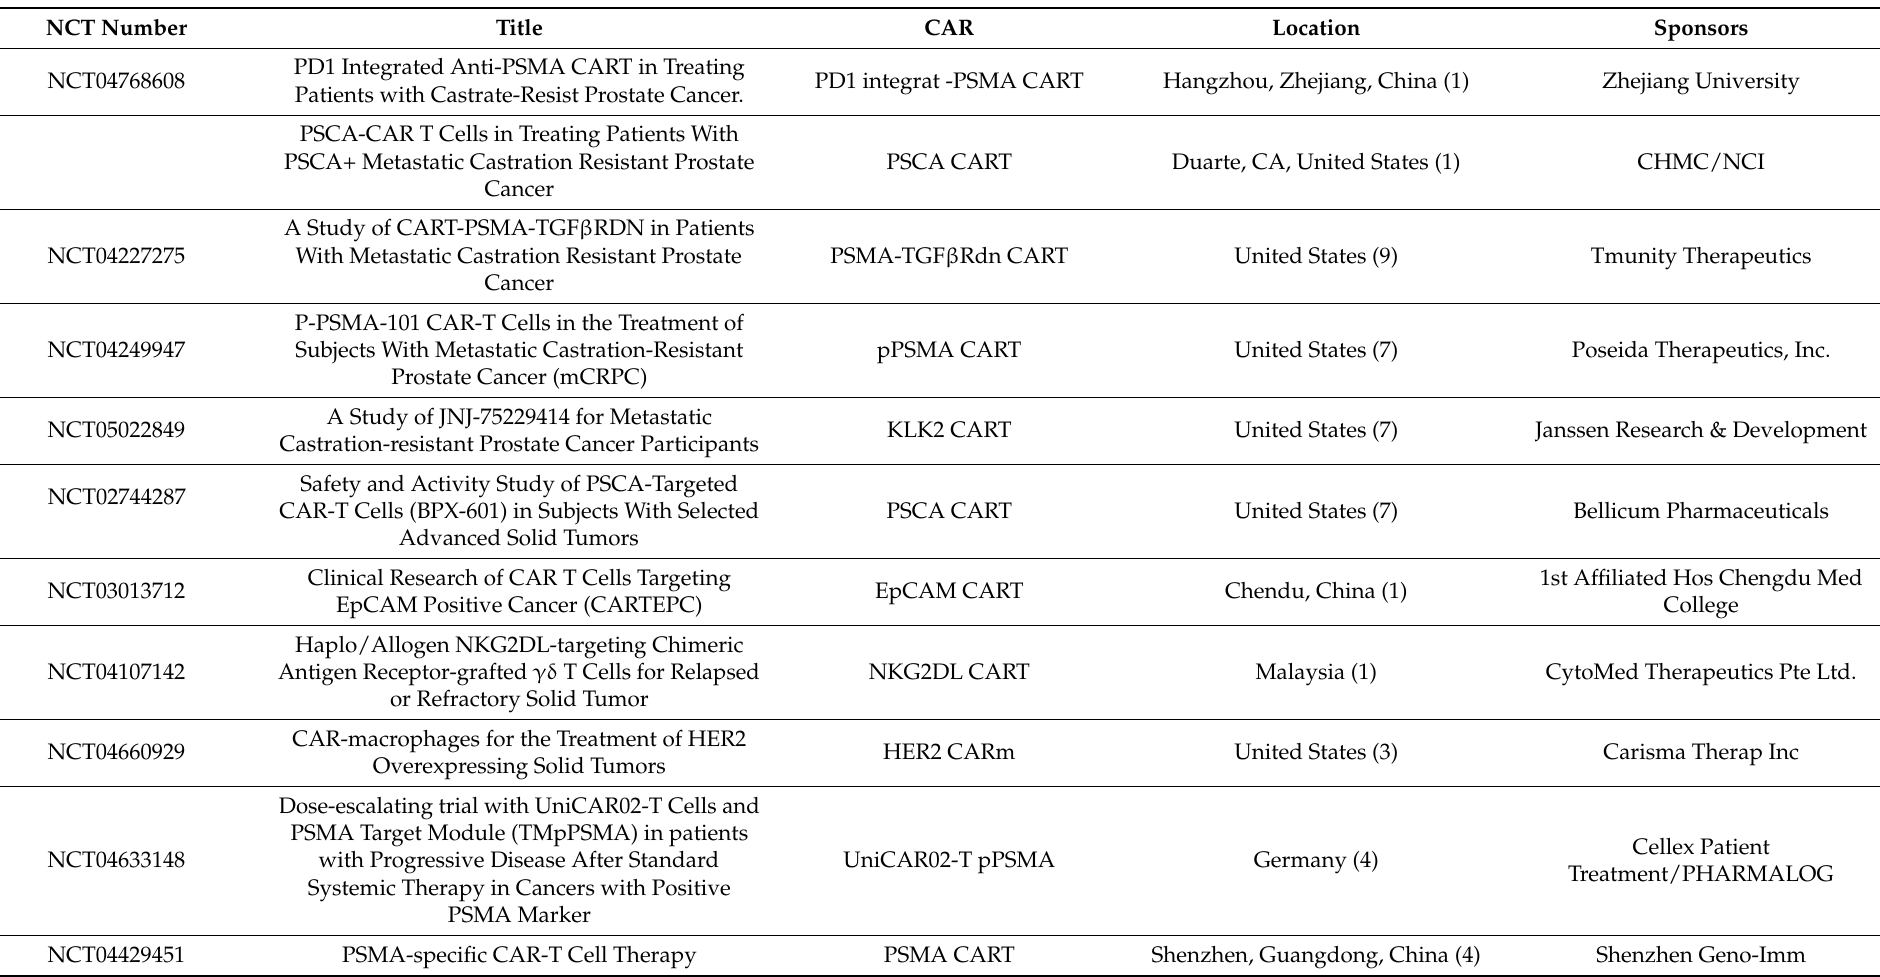
Table 2. Ongoing clinical trials with CAR-T therapy in metastatic castration-resistant prostate cancer. CARm: CAR macrophages; CHMC: City of Hope Medical Center; EpCAM: epithelial cell adhesion molecule; KLK2: Kallikrein 2; NCI: National Cancer Institute; PSCA: prostate stem cell antigen; PSMA: